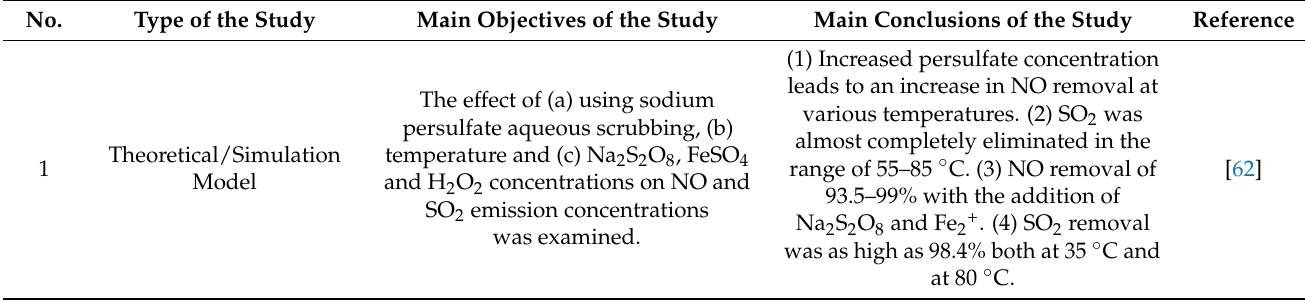
Table 5. Consolidation of the results of the literature review on scrubber systems. For each study listed in this table its type (theoretical, experimental or review study), its main objectives and its main conclusions along with its citation is